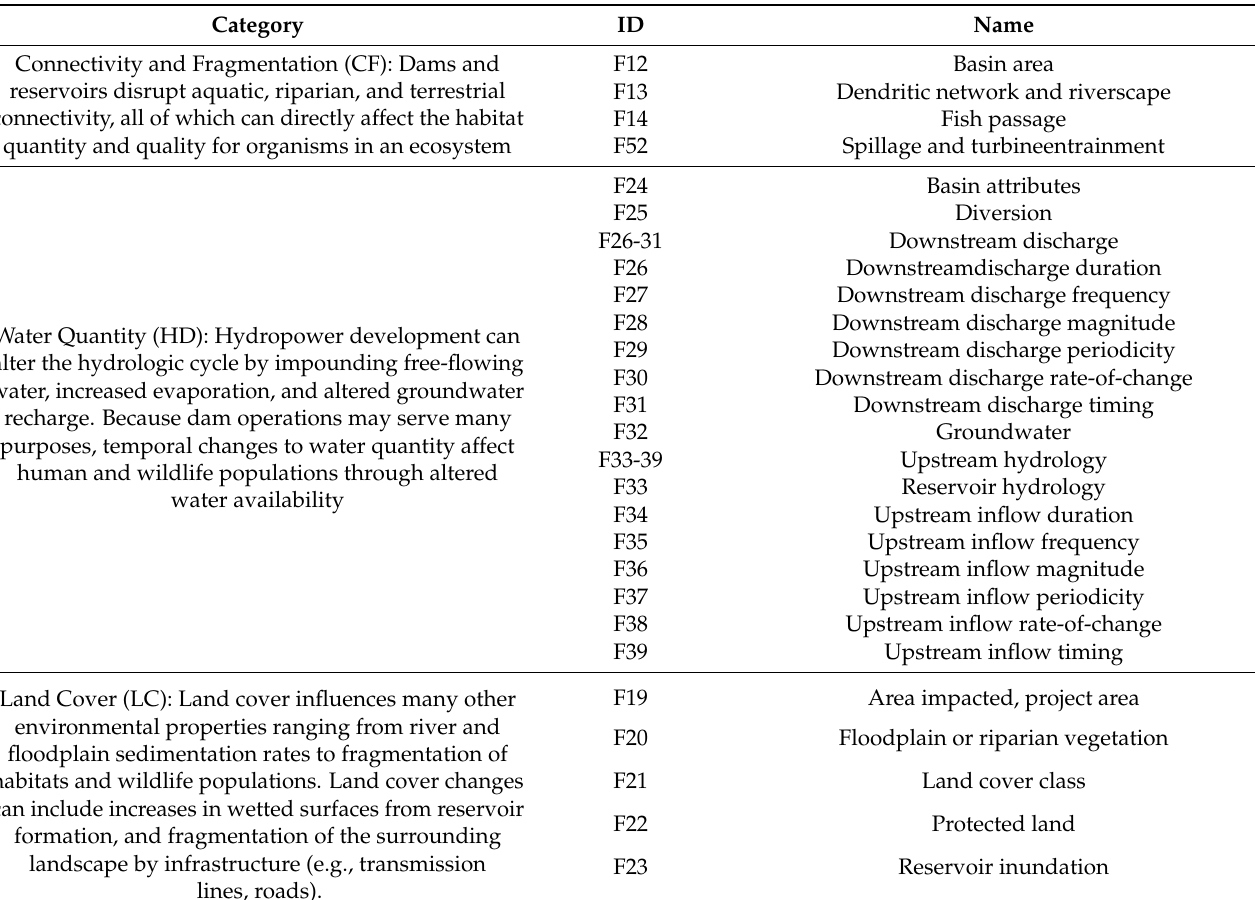
Table 2. Number of questions within each section of the spreadsheet tools (“Existing” refers to the spreadsheet program for existing dams whereas “New” refers to the program for new development) and their relationship to each river function indicator category.